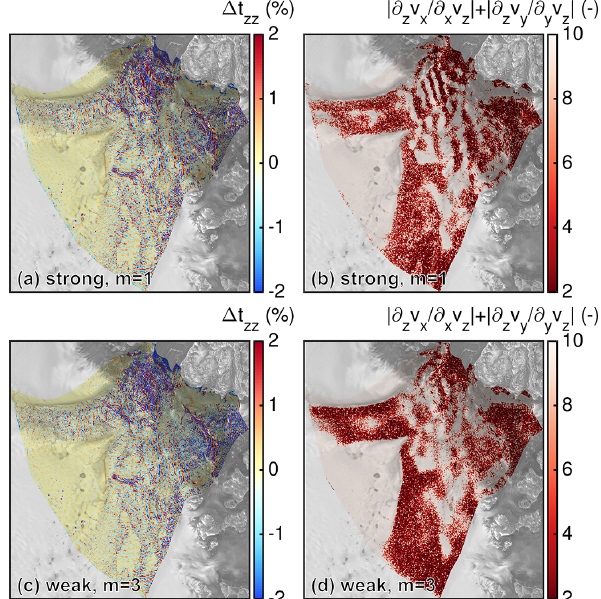
Figure 15. Comparison of (a, c) relative difference of t zz at the ice base between FS and BP-like and (b, d) ratio of vertical gradient of the horizontal velocity to horizontal gradients of the vertical veloc- ity ( | (∂v x /∂z)/(∂v z /∂x) |+| (∂v y /∂z)/(∂v z /∂y) | ) in absolute terms from the FS solution. Panels (a) and (b) show results for l = 150m, E = 1, m = 1 and P1P1GLS strong. Panels (c) and (d) show results for l = 150m, E = 1, m = 3 and P1P1GLS weak. Background